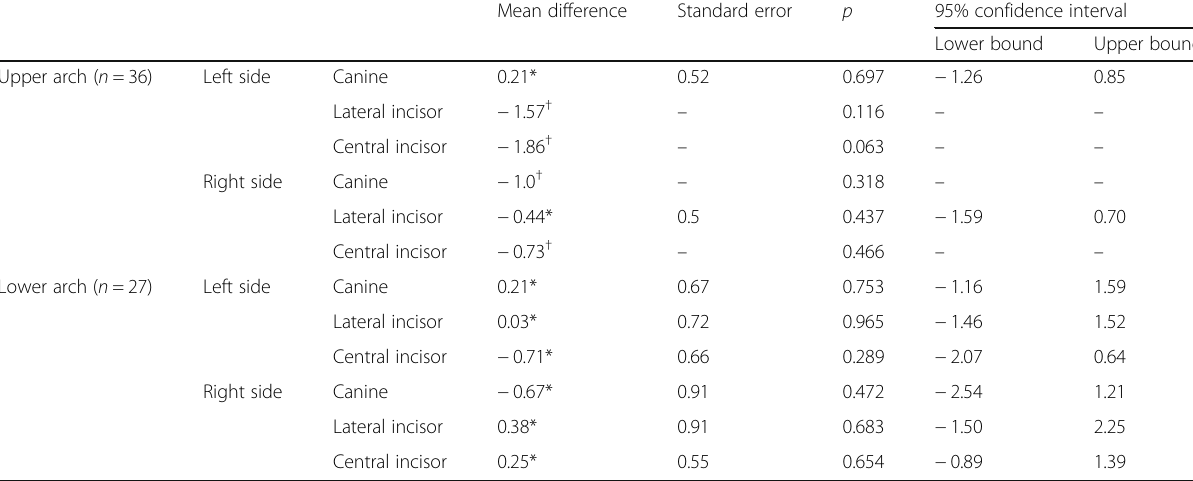
Table 3 Paired t test for the comparison of the predicted (TS) and achieved (T1)